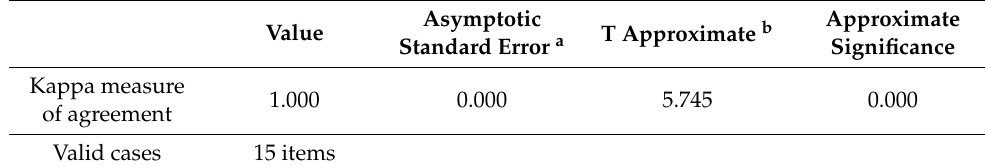
Table 1. Content validity analysis (results of external